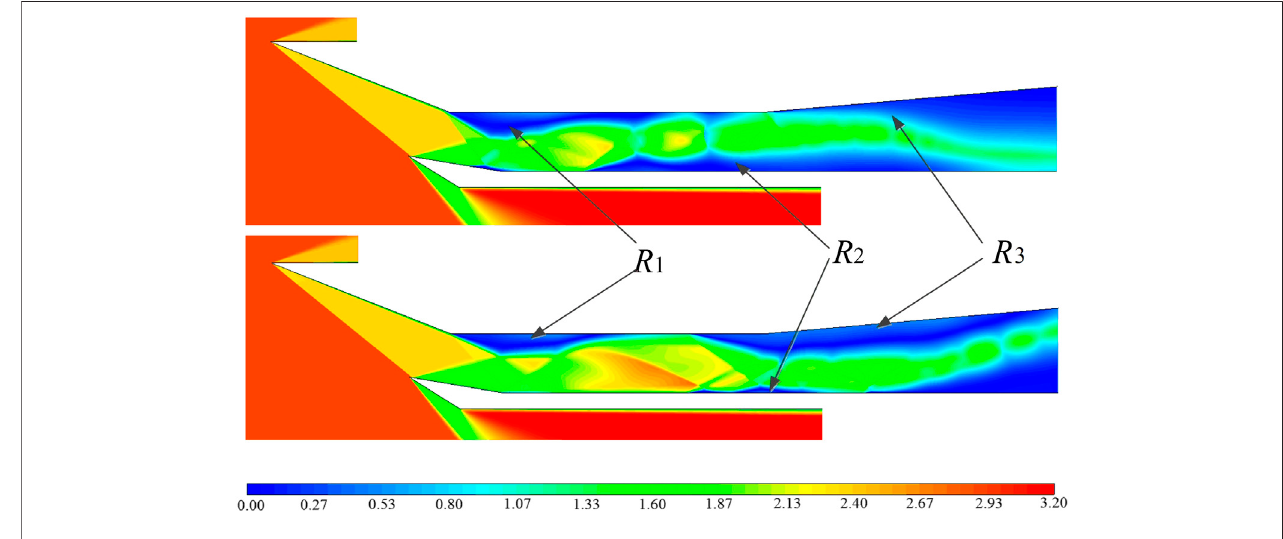
FIGURE 12 | Typical Mach number contours of Model A at different times.